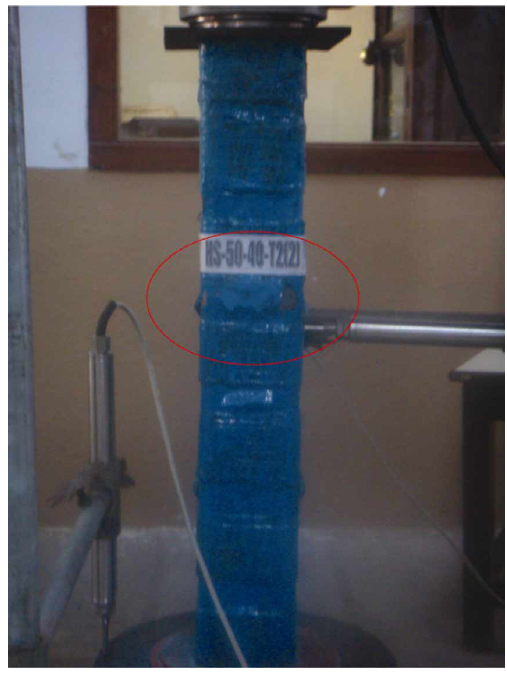
Fig. 9. Failure mode of column